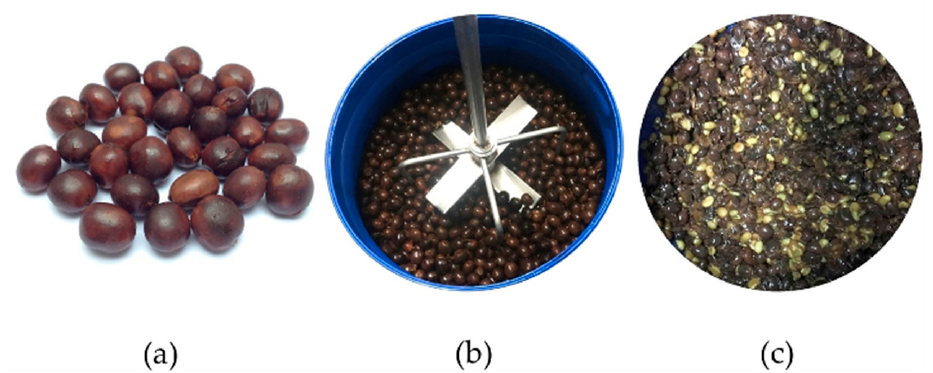
Figure 1. Defrosted coffee cherries ( a ), mashing of coffee cherries ( b ) and disintegrated beans and pulps after mashing ( c ).